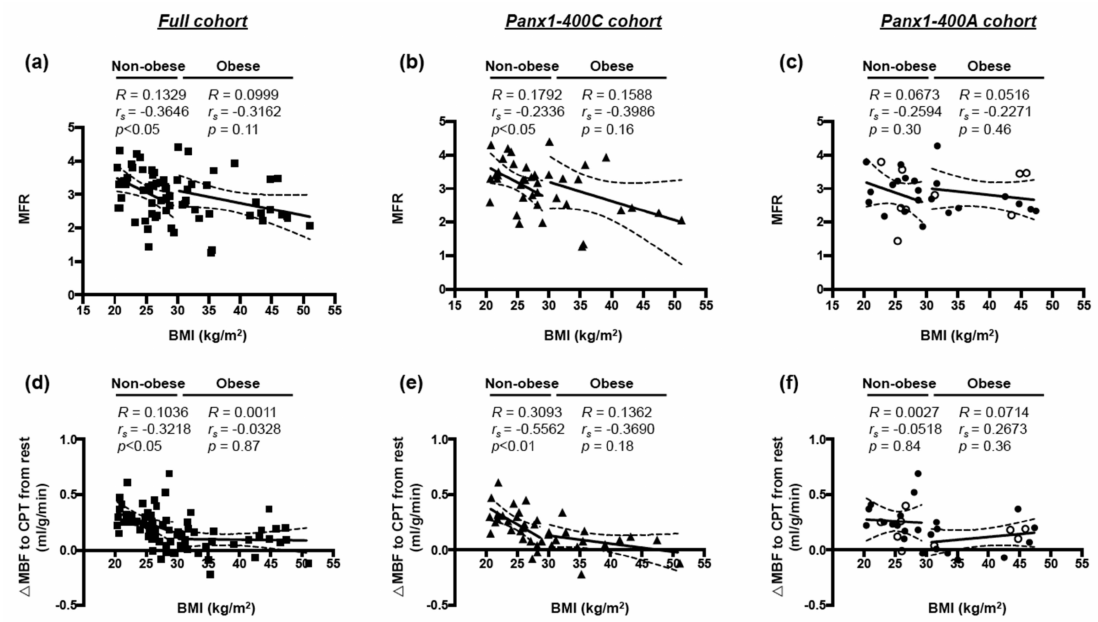
Figure 3. Correlation between BMI and MFR or endothelial function. Spearman correlations between body mass index (BMI) and myocardial flow reserve (MFR, ( a – c )) or endothelial function ( ∆ MBF to CPT from rest, ( d–f )) in non-obese and obese subjects in the full cohort (( a , d ) n = 43 and 29, respectively), the Panx1-400C cohort (( b , e ) n = 25 and 15, respectively) and the Panx1-400A cohort (( c , f ) n = 18 and 14, respectively). AA genotype: open circles; AC genotype: closed